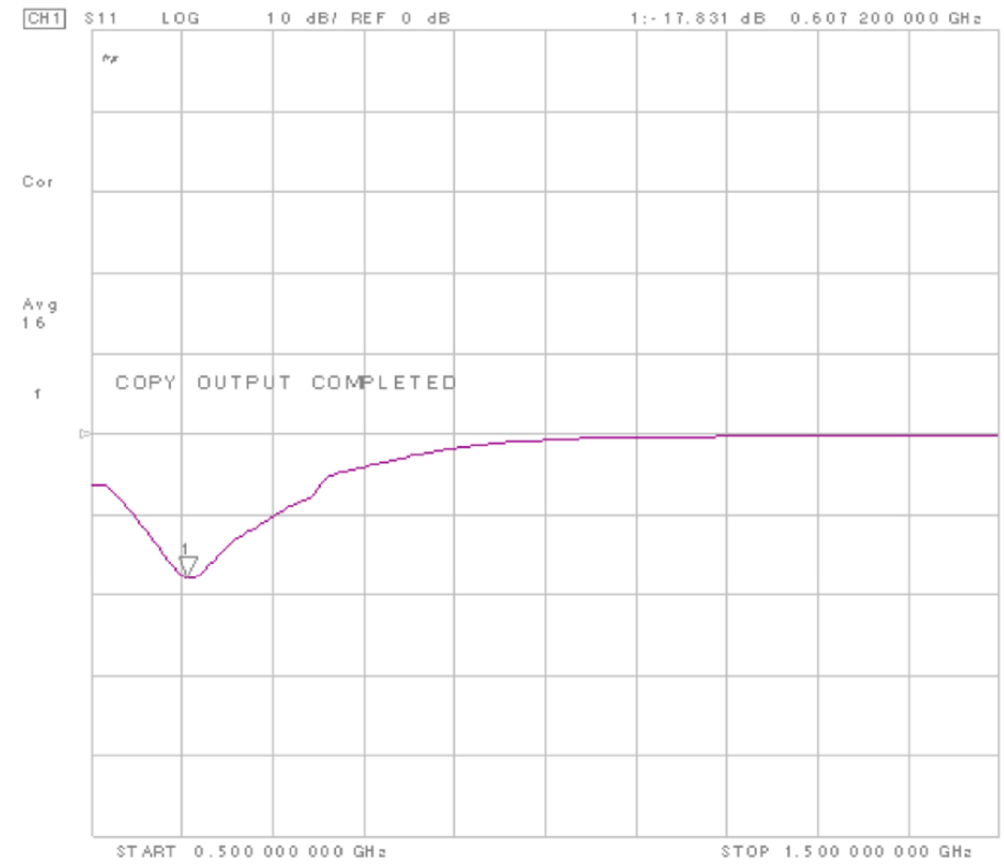
Figure 6. Measured input match (S11) of the RFED WuR. It can be seen that the input match is deviated to lower frequencies, with a valley centered at 607 MHz instead of 868